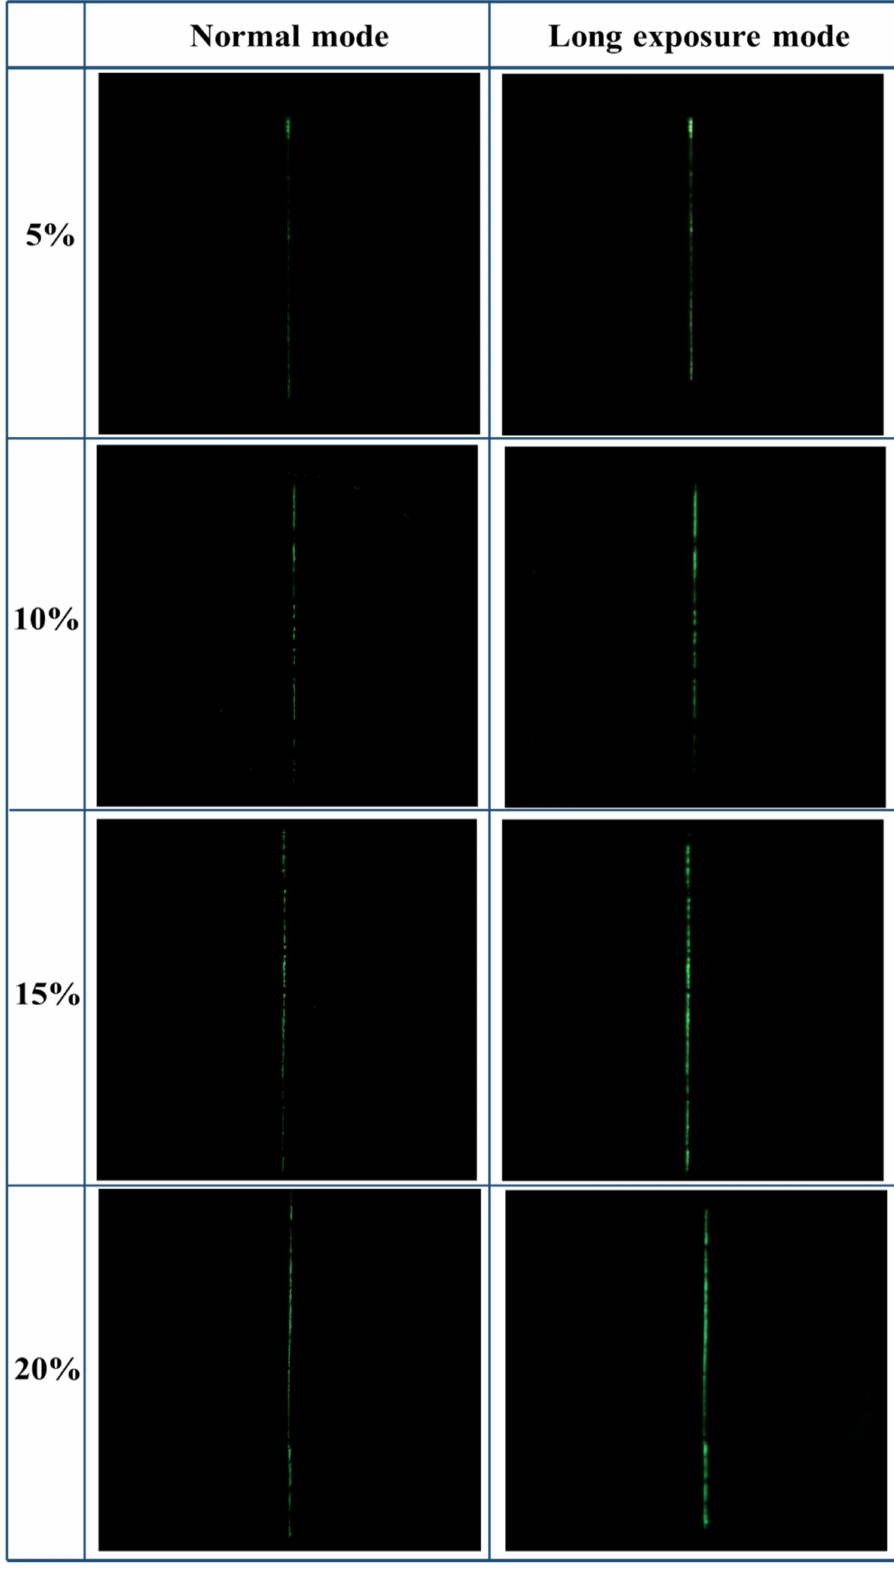
Figure 9. The damage indicating effect of coatings with different TSF microcapsule contents taken in normal mode and long exposure